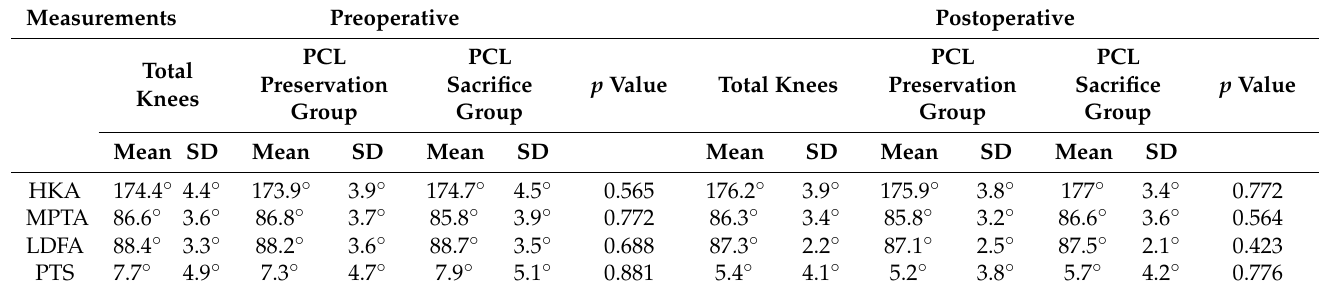
Table 2. Preoperative and postoperative radiographic data in the PCL preservation and PCL sacrifice